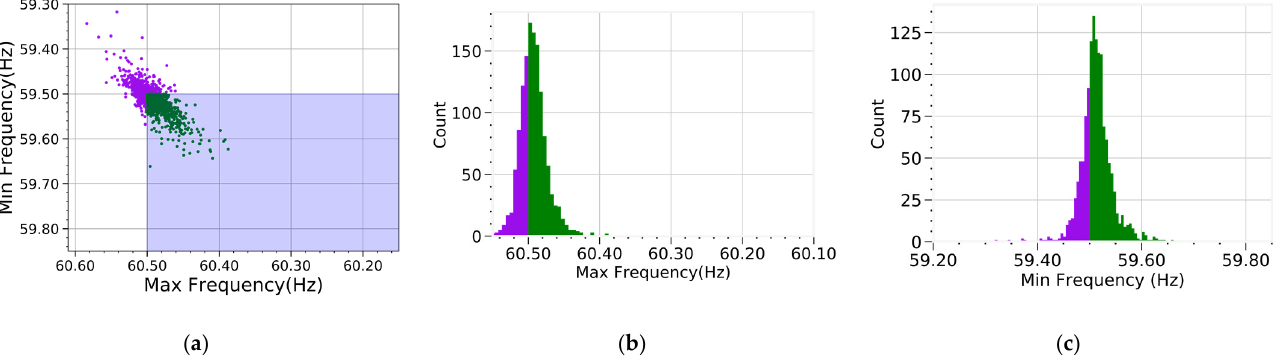
Figure 11. Maximum and minimum frequency and histograms of Island 1 and Island 2: N = 1 (purple: outside secure region, green: inside secure region, shaded area: secure region). ( a ) Max. and Min. frequency; ( b ) Max. frequency histogram in Island 1; ( c ) Min. frequency histogram in Island